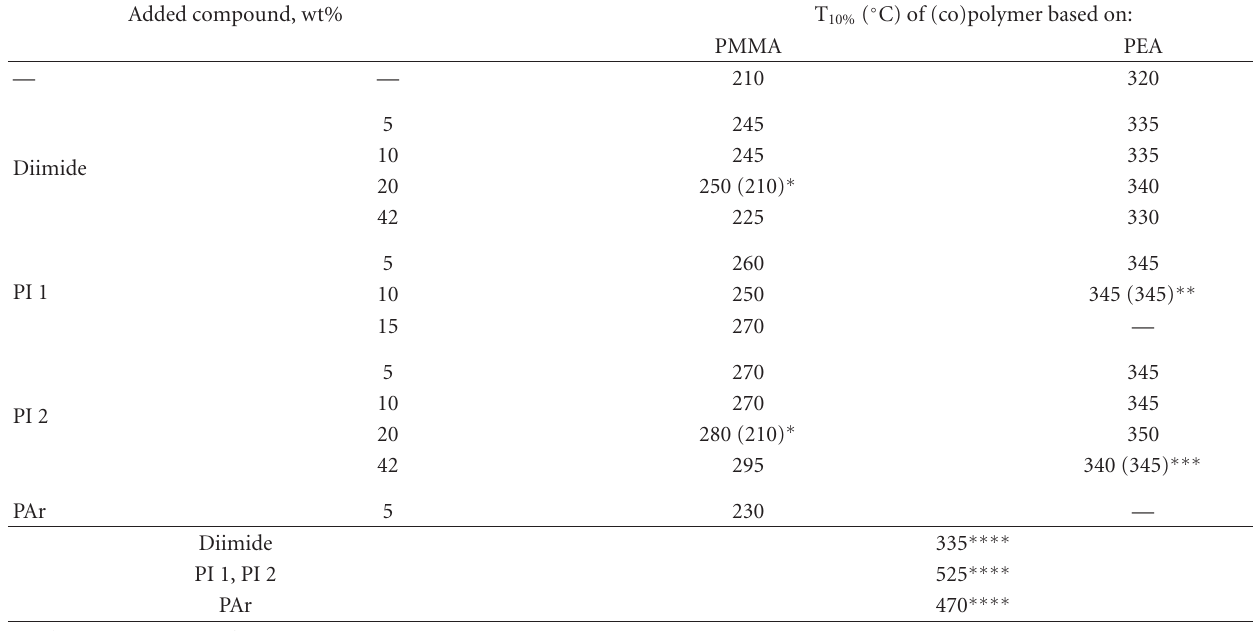
Table 4: 10% weight loss temperature of polymers obtained by polymerization of MMA and EA in the presence of DI, PI 1, PI 2, and PAr. Added compound, wt%